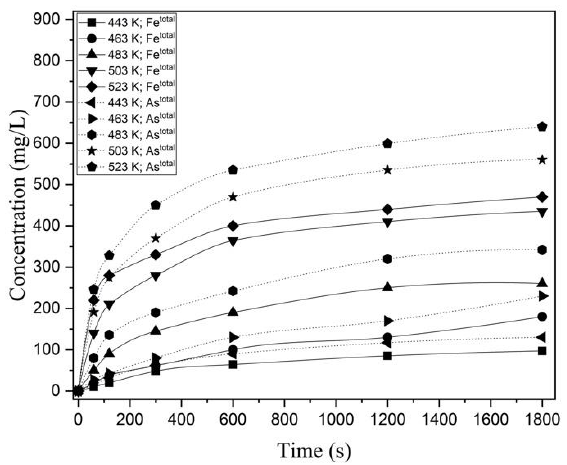
Figure 8. Concentration of As and Fe as a function of the process time at different temperatures (443 – 523 K; 100 rpm, 0,1 mol/L of H 2 SO 4 ; 0,16 mol/L of Cu; 10 –29 μm).